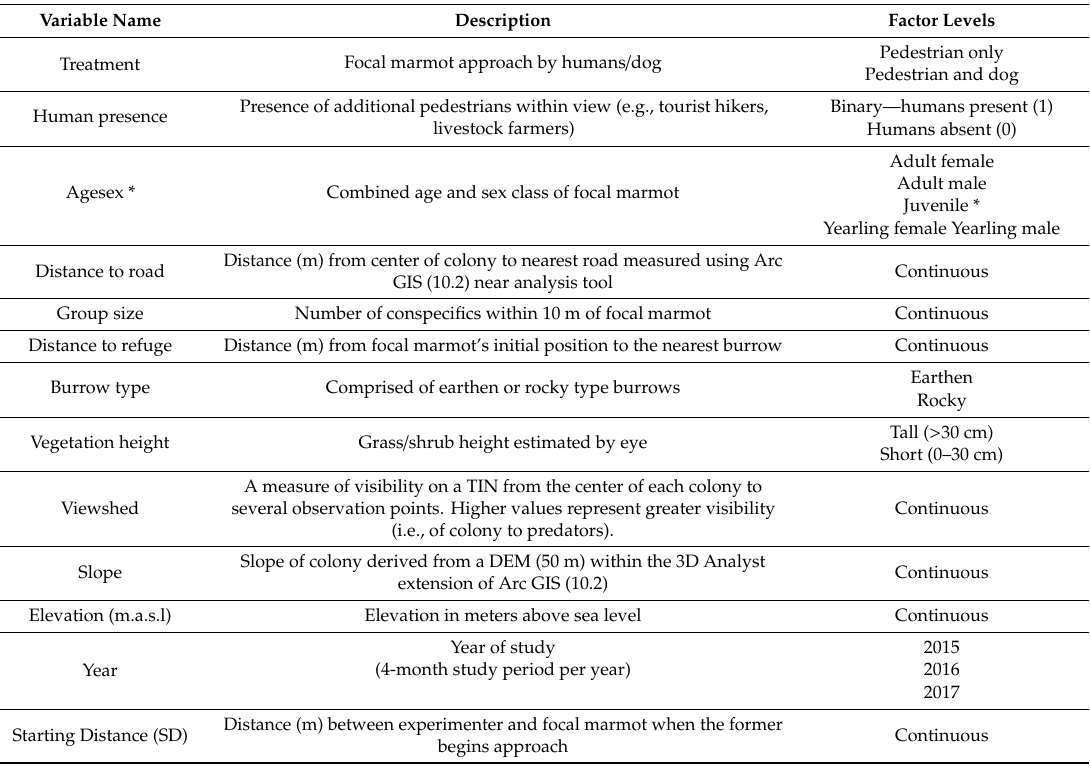
Table 1. List and description of all candidate fixed main e ff ects for predicting Flight Initiation Distance (FID) in golden marmots. * not possible to determine sex in juveniles; TIN = triangulated irregular network; DEM (50 m) = digital elevation model at the scale of 50